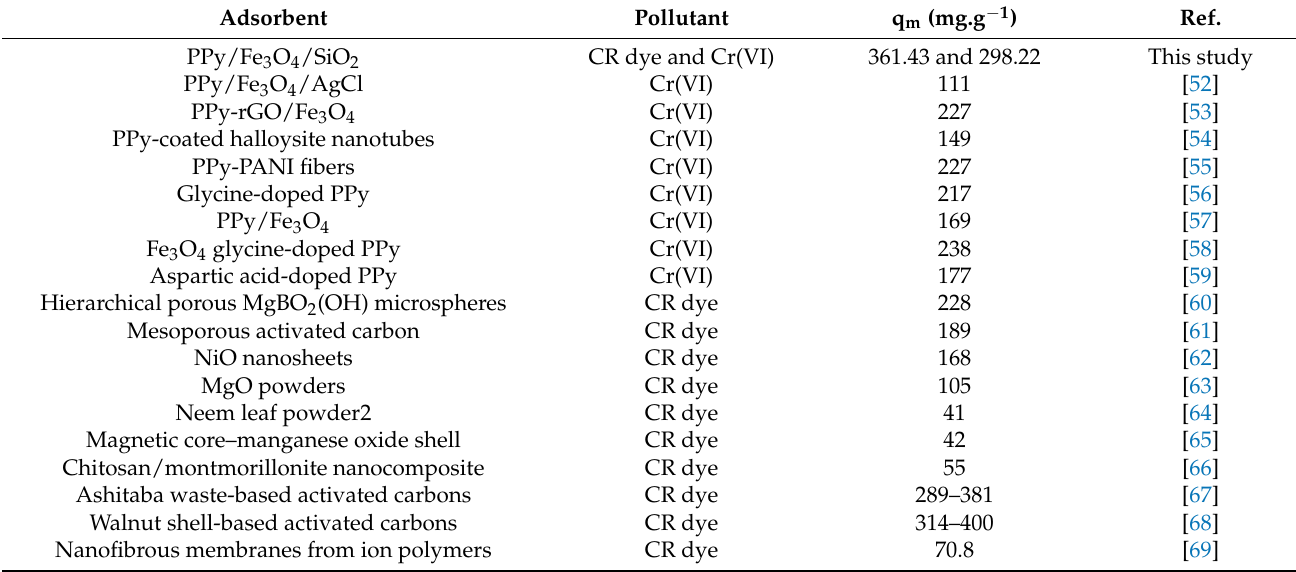
Table 2. Comparative assessment of CR dye and Cr(VI) ions adsorption capacity of PPy/Fe 3 O 4 /SiO 2 nanocomposite with previously reported